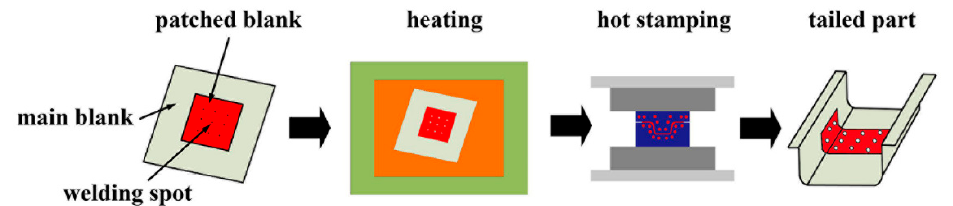
Figure 1. Process flow chart of the hot stamped ultra-high strength steel patchwork blanks